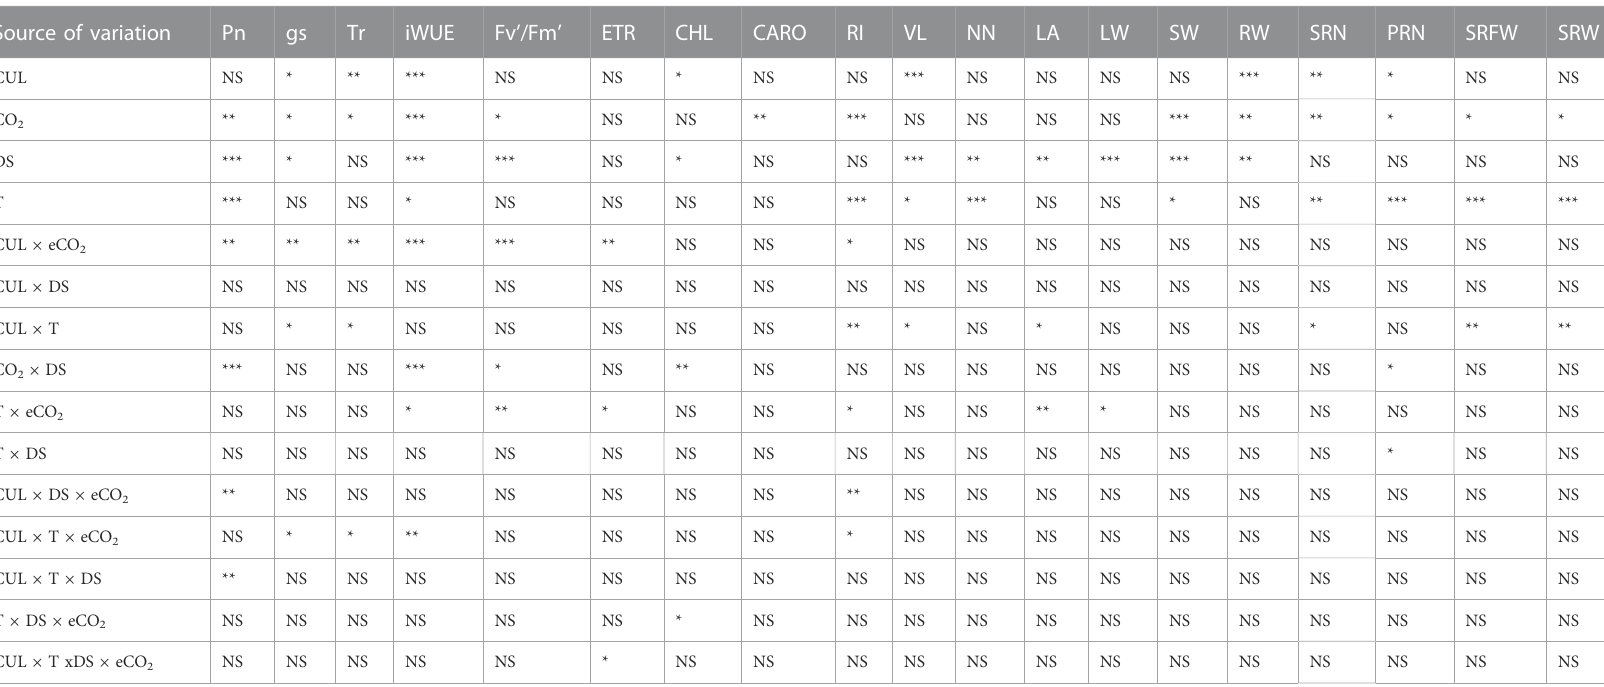
TABLE 2 The analysis of variance across the treatments of temperature (T), carbon dioxide concentration ([CO 2 ]), drought (DS), and cultivars (CUL), and their interactions on sweetpotato vegetative, physiological, and photosynthetic parameters. Source of variation CUL